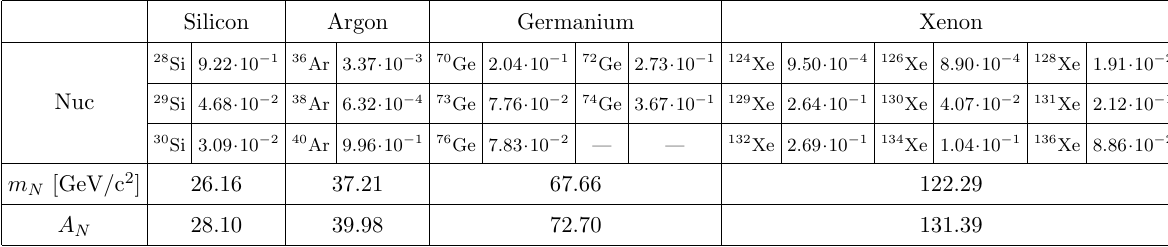
Table 1 . Silicon, argon, germanium and xenon stable isotopes along with their relative abun- dances. Nuclear mass and mass numbers are calculated by averaging over the relative abundance of each